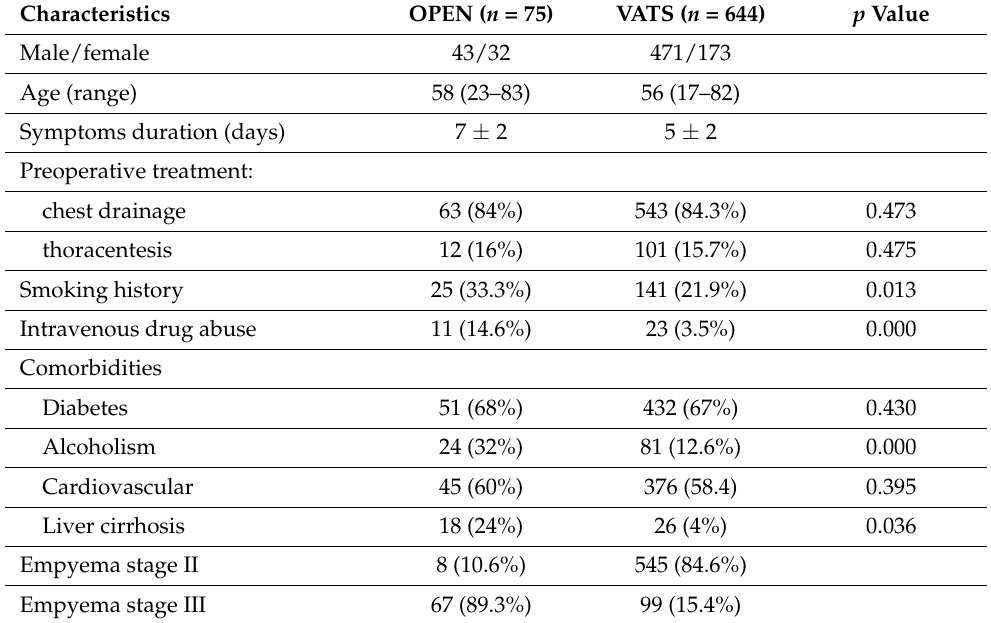
Table 1. Preoperative patients’ characteristics.